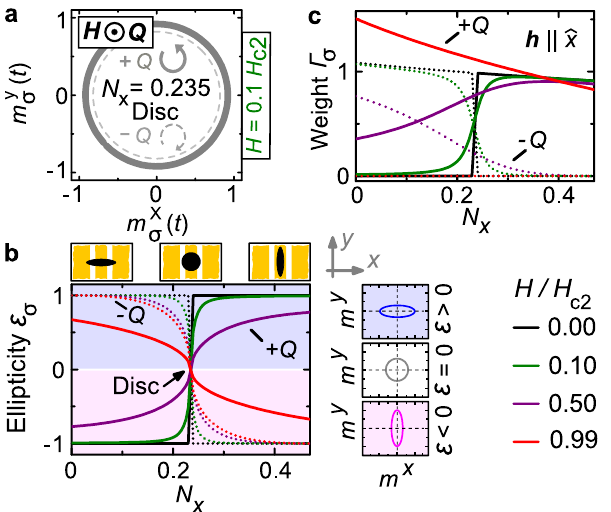
Figure 3. Ellipticity and spectral weight. ( a ) Dynamic components of the circularly polarized modes + Q and − Q in a round, flat sample ( N = N < N x y z ) with a small field H applied along ˆ z . The width of lines indicates the relative signal strength. ( b ) Ellipticity ε σ of the conical modes as a function of the demagnetization factor N x ( N z = 0.53) calculated for different magnetic fields (colors). Solid and dotted lines represent modes + Q and − Q, respectively. The insets illustrate the sample shapes corresponding to N x (top) and the elliptic trajectories of the average spin precessional motion (right). ( c ) Spectral weight Γ σ of the conical modes (arb. units) for an excitation field h along ˆ x